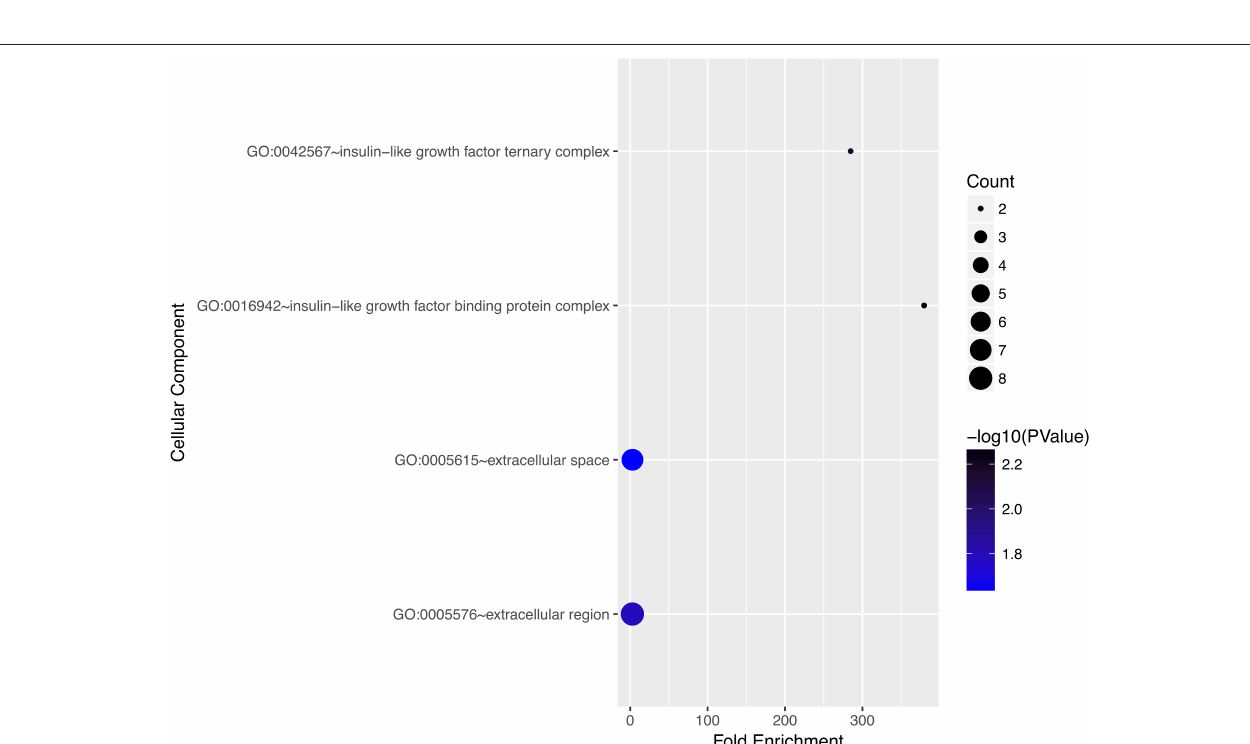
FIGURE 3 | Gene ontology analysis for cellular component of genes involved in the ceRNA network in ACC.